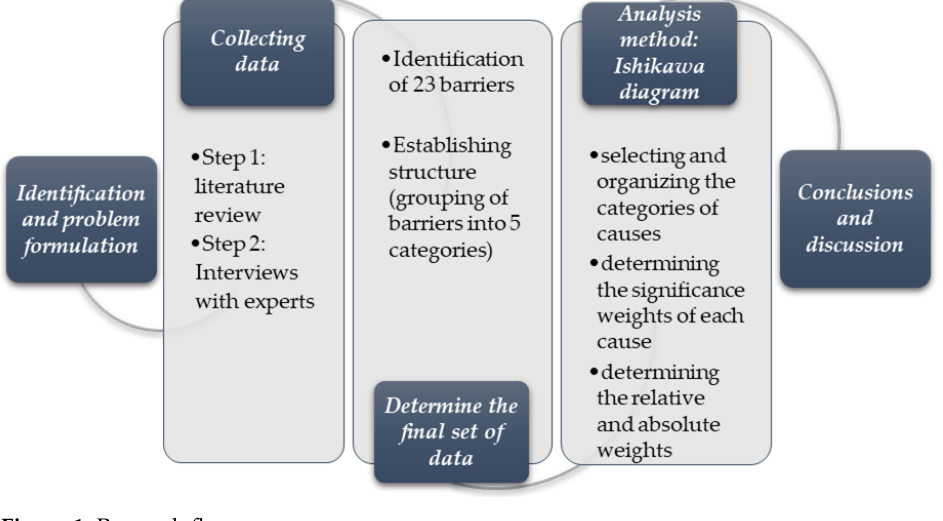
Figure 1. Research flow.